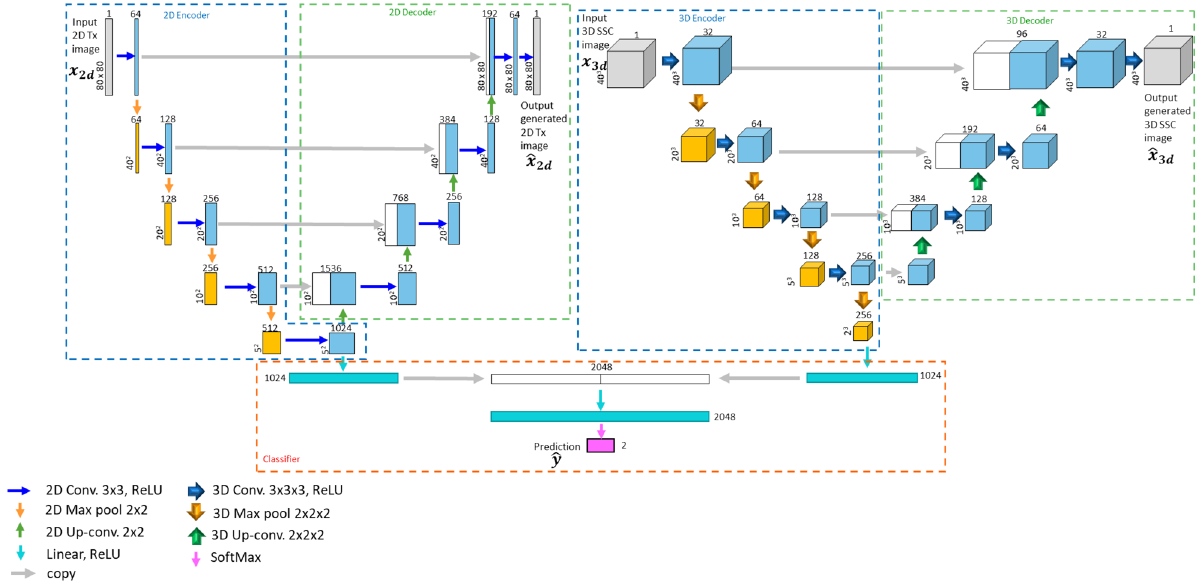
Figure 3. Fused UNet autoencoder model